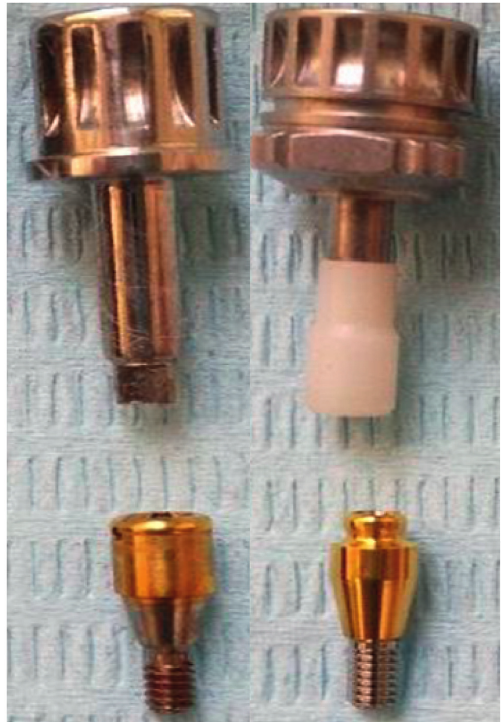
Figure 2: OT Equator (right) and Locator (left) abutments with mounting